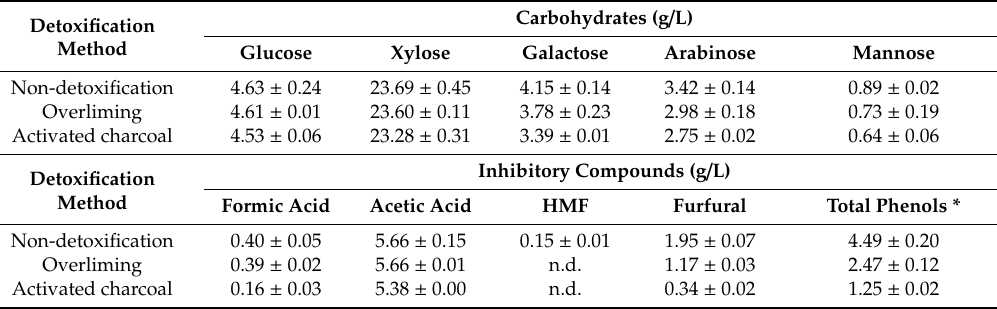
Table 1. Composition of acid hydrolysate before and after